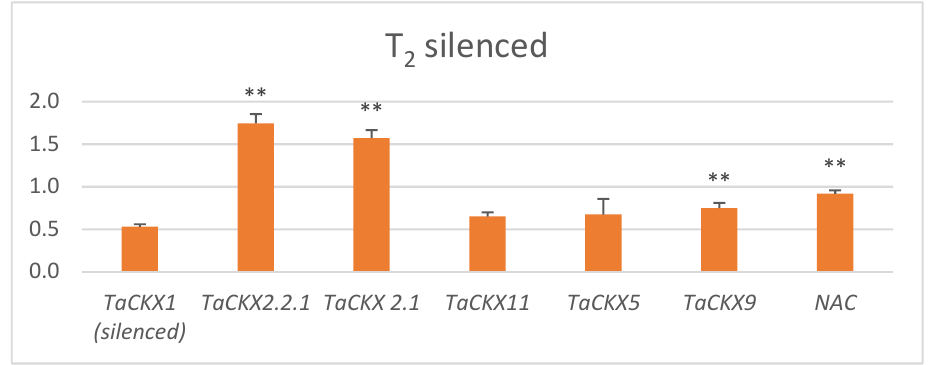
Figure 1. Relative values of expression of TaCKX1 and other TaCKX GFMs, and NAC in silenced TaCKX1 lines of T 2 . The error bars denote ± SE. Significantly different from silenced gene: ** significant at p ≤ 0.01; N 12 (N—number of objects/tested lines).